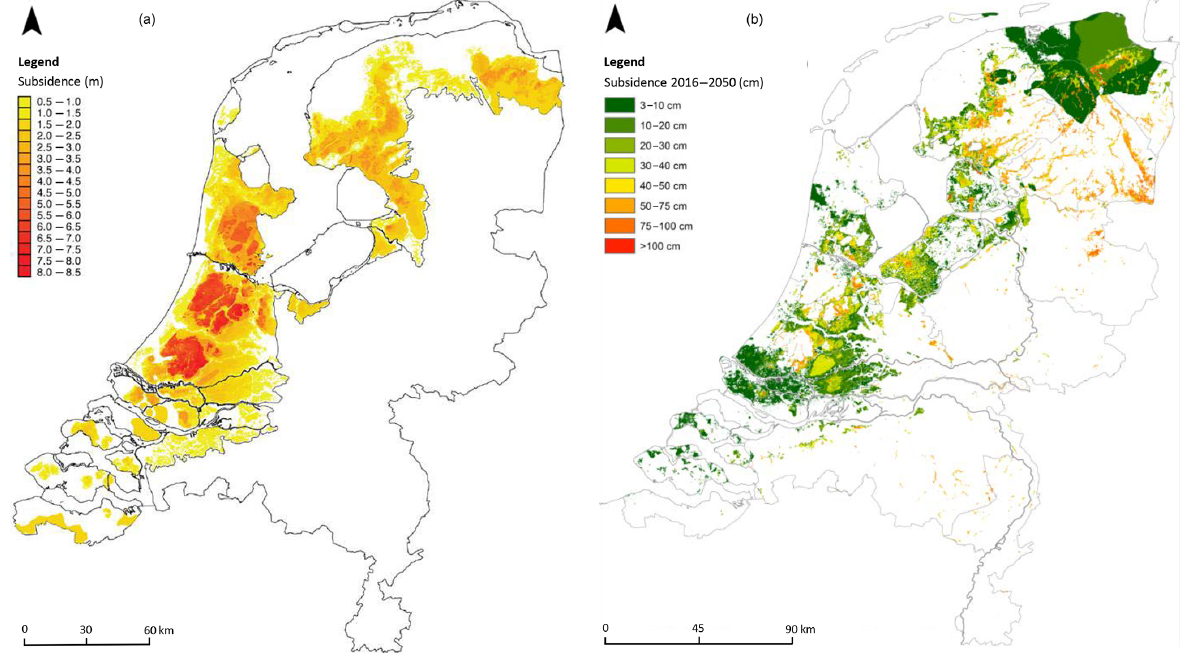
Figure 1. (a) Land subsidence over the last 1000 years in the coastal peat lands of the Netherlands due to drainage, loading and peat mining (Erkens et al., 2016). (b) Prediction of the amount of land subsidence for the coming decades, showing land subsidence of soft soils, salt mining and gas extraction (Erkens et al., 2017).